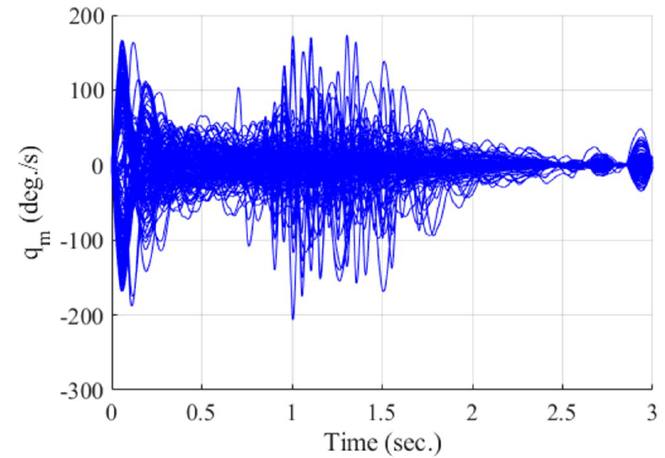
Figure 18. Pitch rate of the missile (Monte Carlo